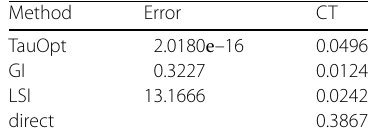
Table 3 Errors and CT for Example